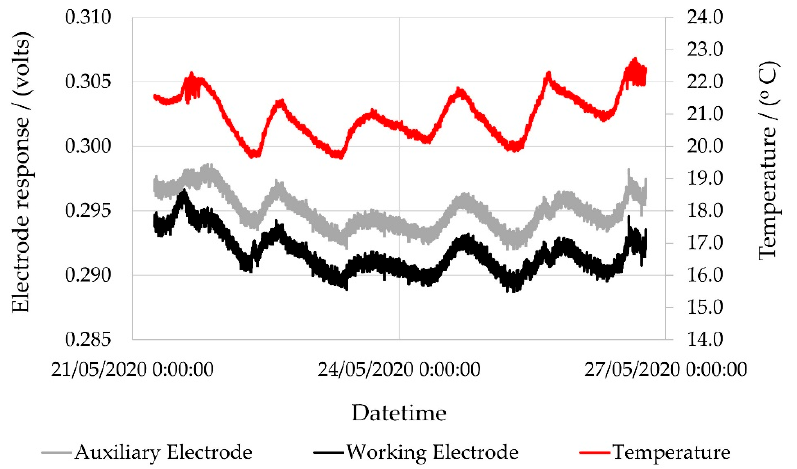
Figure 4. Temporal changes in NO electrochemical electrode responses due to changing temperature (dT = ±1.2 °C).